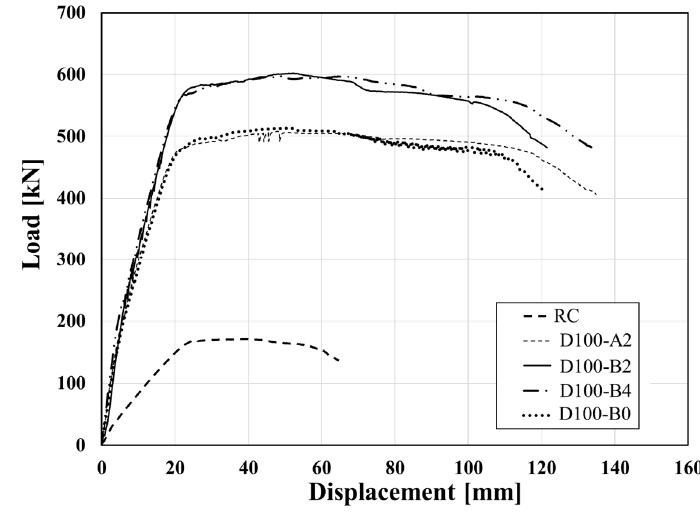
Figure 14. The load-deflection curve test results. Table 6. Flexural test results.